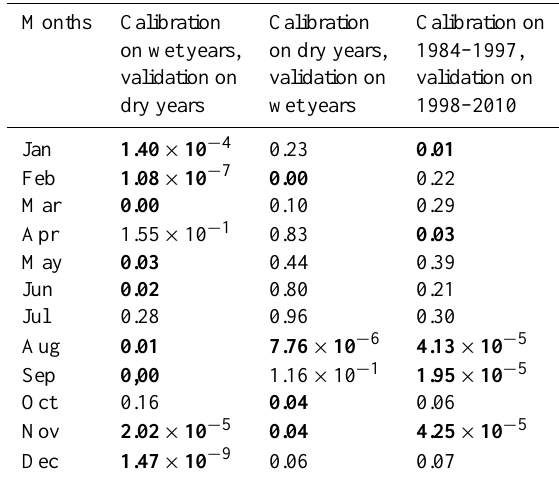
Table 4. p values of the Kolmorogov-smirnov test obtained after bias-correction of MED11-EVAL precipitation (values in bold indi- cate significant differences, at the 5% level, between the observed and bias-corrected daily